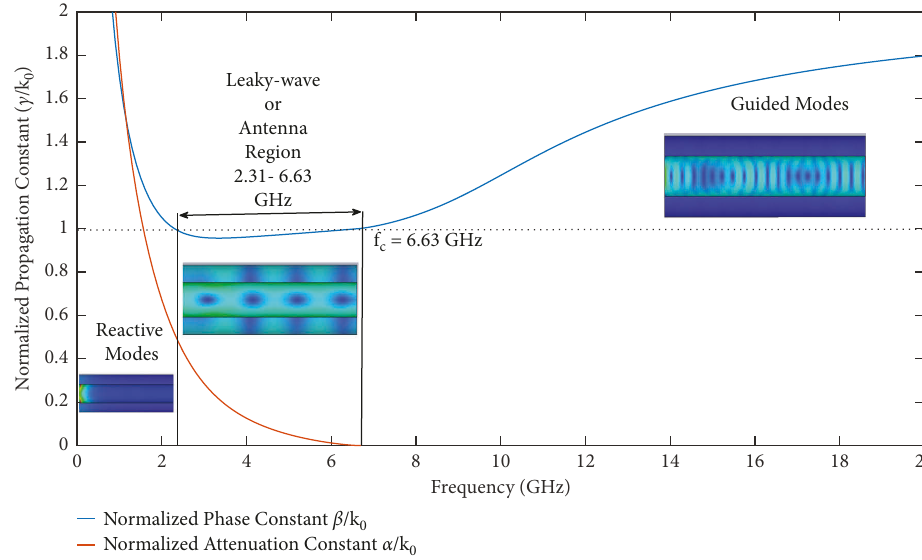
Figure 3: Leaky-wave characteristic of TM